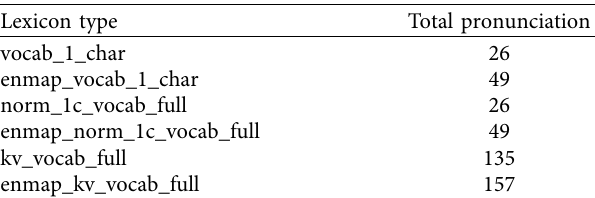
Table 5: Total pronunciations in the